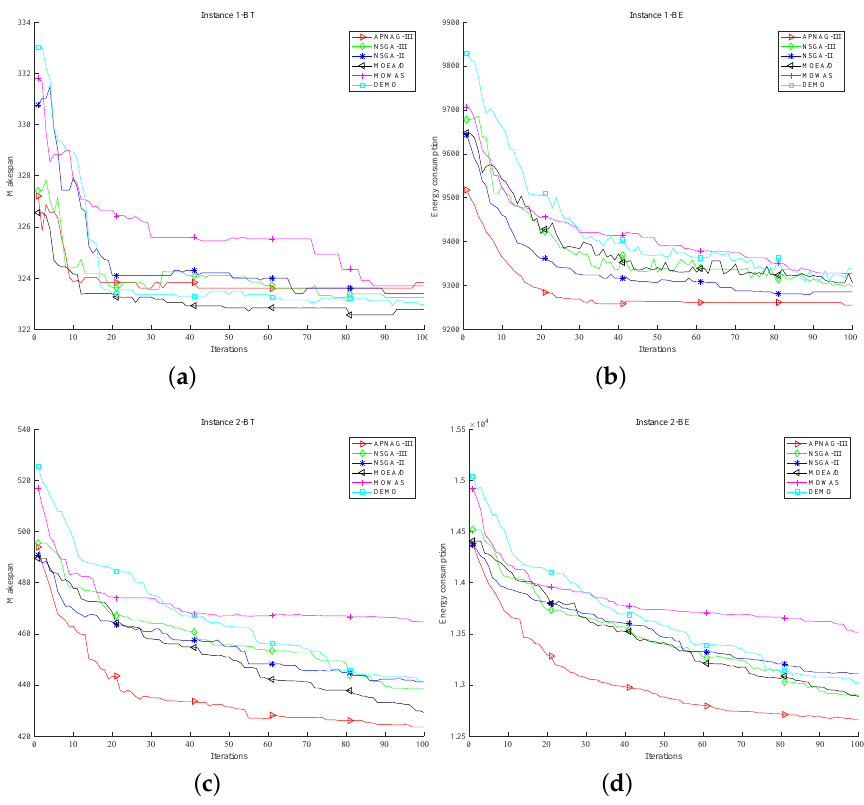
Figure 5. The convergence curve of BT and BE for Instance 1 and Instance 2. ( a ) BT of Instance 1; ( b ) BE of Instance 1; ( c ) BT of Instance 2; ( d ) BE of Instance 2.